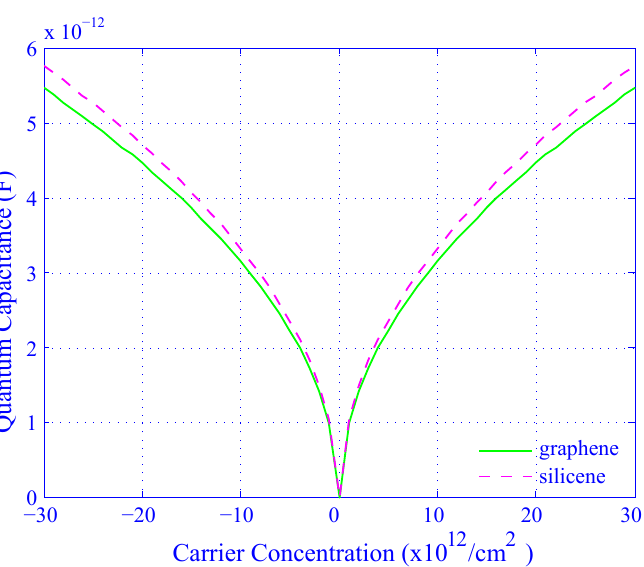
Figure 6. Effect of carrier concentration on quantum capacitance for both silicene (dotted line) and graphene (solid line).